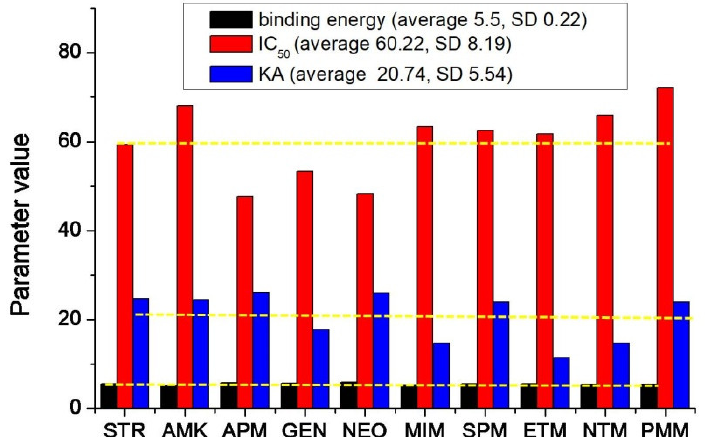
Figure 7. Change trends of the binding energy, absolute affinity constants (KA), and IC50 for the 10 AGs. (The yellow line is the average value of each parameter).